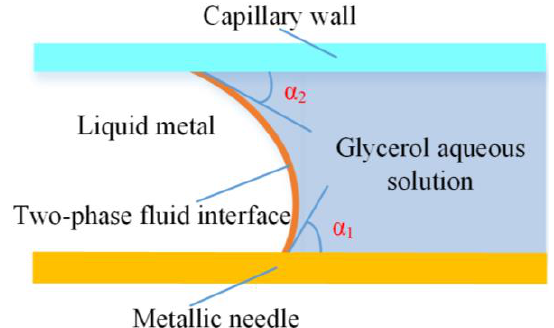
Figure 3. The contact angle between the liquid metal and the metallic needle, and capillary wall, respectively.